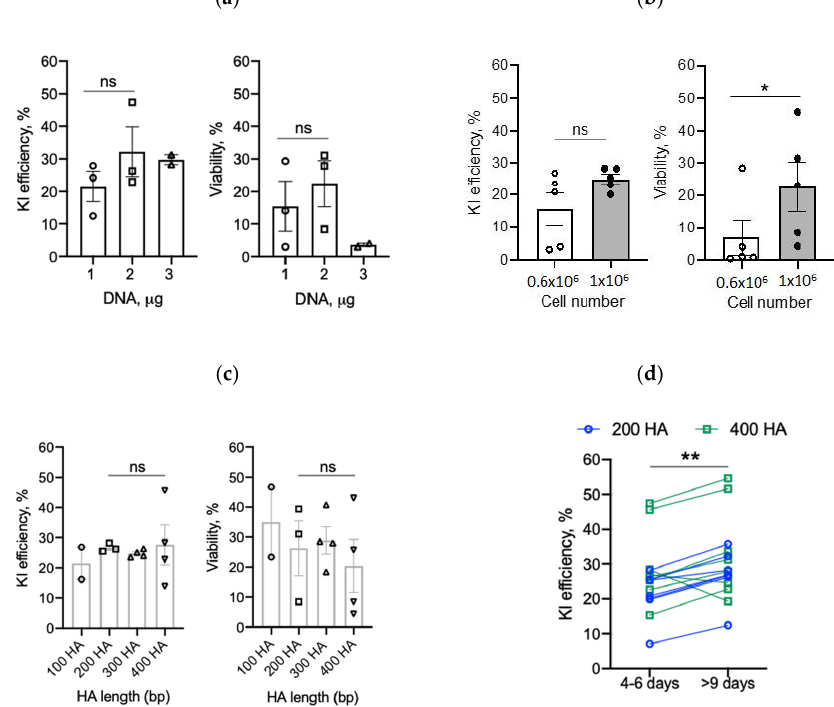
Figure 4. Optimization steps to increase transgene knock-in (KI) e ffi ciency in T cells: ( a ) Three di ff erent dsDNA template concentrations were evaluated for the best knock-in e ffi ciency and cell viability ( n = 3 for 1 and 2 µ g, n = 2 for 3 µ g; two-tailed t -test; ns—not significant). ( b ) Two di ff erent numbers of T cells were tested for electroporation ( n = 5, two-tailed paired t -test, * p = 0.041). ( c ) Four di ff erent lengths of homology arms flanking the transgene of interest were evaluated ( n = 2–4, one-way ANOVA, ns—not significant). ( d ) Knock-in e ffi ciency was tested at early (4–6 days) and late ( > 9 days) time points post-electroporation ( n = 15, two-tailed paired t -test; ** p =